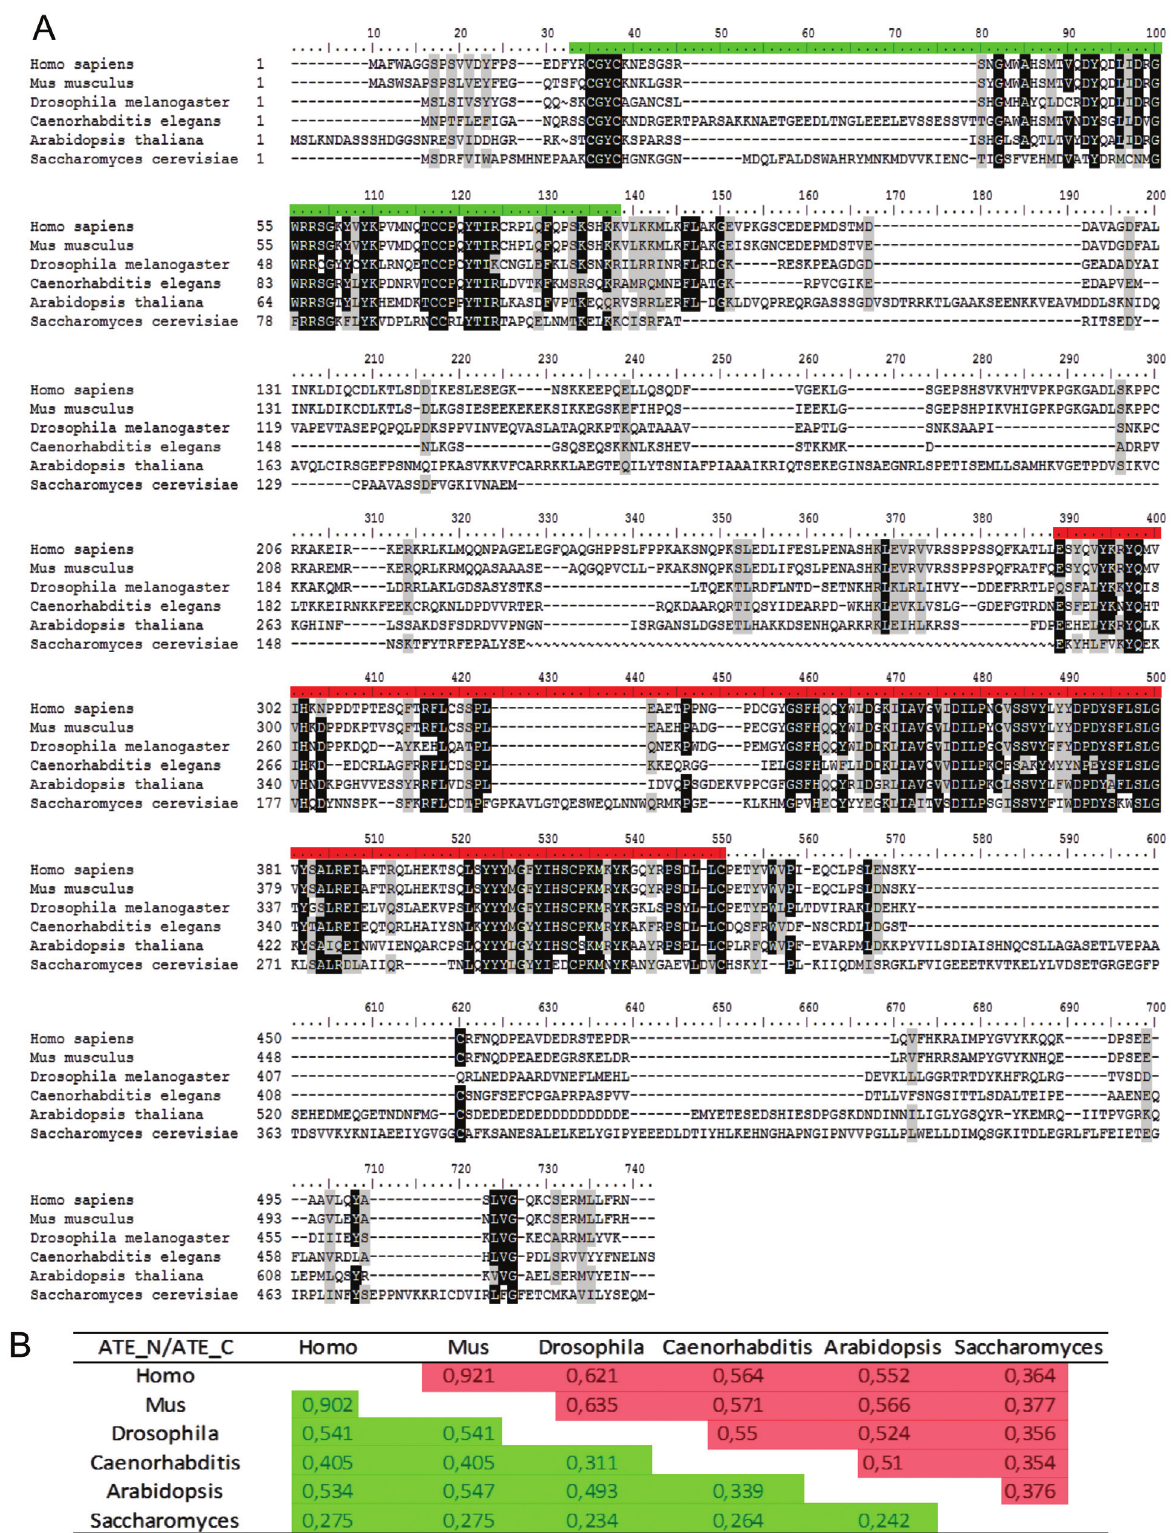
Figure1 -ATEproteinsequencesacrossdistinctkingdoms.A)AlignmentofATEfull-lengthproteinsequencesfrom Homosapiens (NP_001001976.1), Mus musculus (NP_038827.2), Drosophila melanogaster (NP_477394.3), Caenorhabditis elegans (NP_492549.2), Arabidopsis thaliana (At5g05700) and Saccharomycescerevisiae (AJS07672.1)areshown.GreenandredbarsrepresentATE-NandATE-Cterminaldomains,respectively,asindicatedby PFAM analysis. Columns with 100% and > 80% amino acid identity are shaded in black and gray, respectively. B) Identity values of the ATE-N (green) and ATE-C (red) domains between different